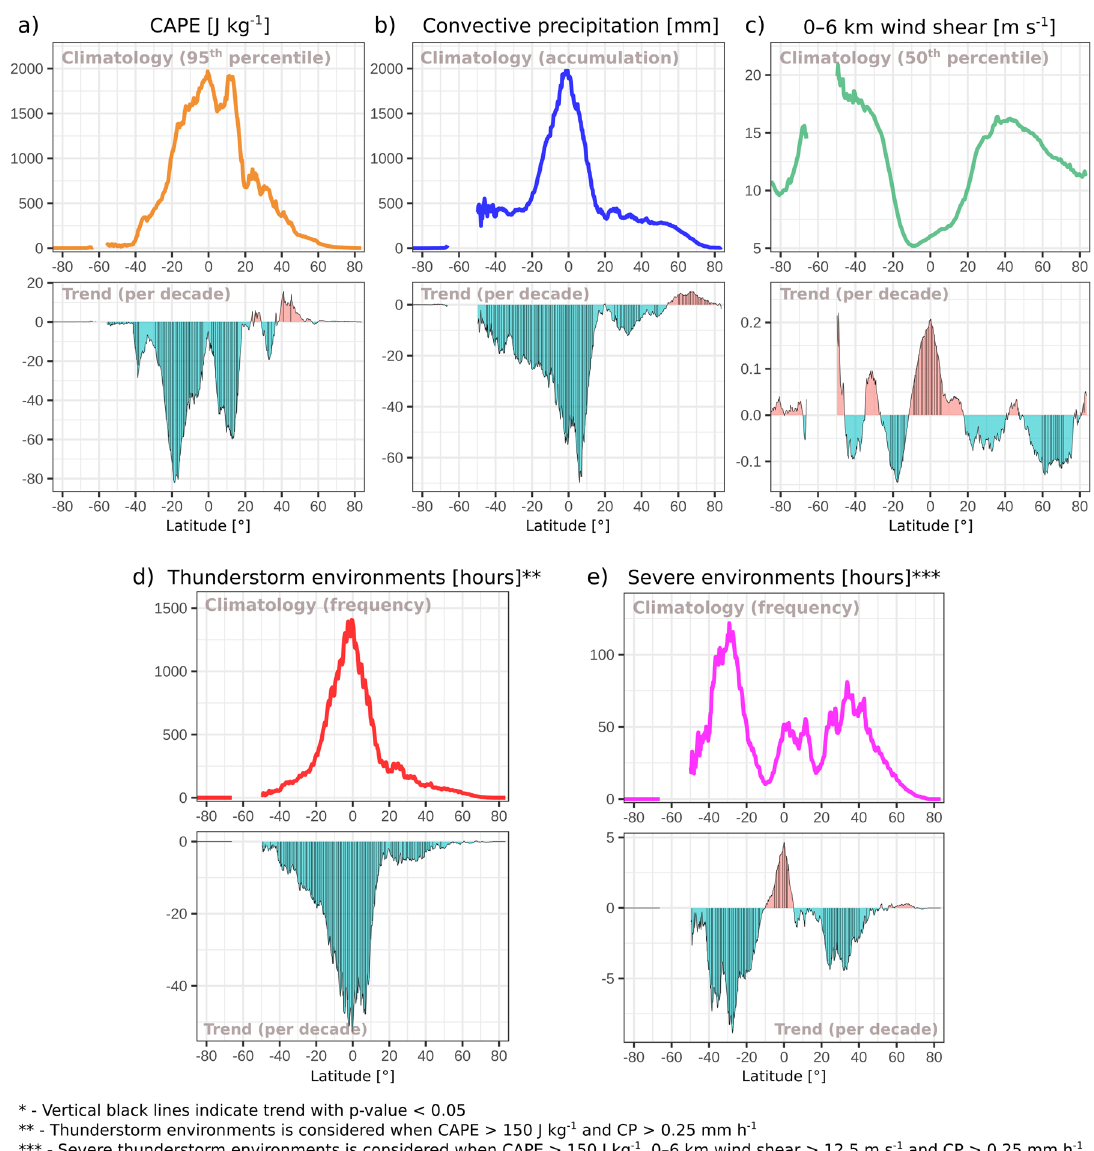
Fig. 4 ERA5 zonal mean climatology and trends for CAPE, convective precipitation, vertical wind shear, thunderstorm and severe thunderstorm environments (land surface grids only). A 41-year (1979 – 2019) zonal mean climatology and trends for ( a ) 95 th percentile of convective available potential energy (CAPE), ( b ) accumulated convective precipitation, ( c ) 50 th percentile of 0 – 6km vertical wind shear, ( d ) frequency of thunderstorm environments, and ( e ) frequency of severe thunderstorm environments. Only grids over the land surface are taken into account (at least 30 in any latitudinal band). Trend is computed using Sen ’ s slope and value denote change per decade. Vertical solid lines indicate p -value below